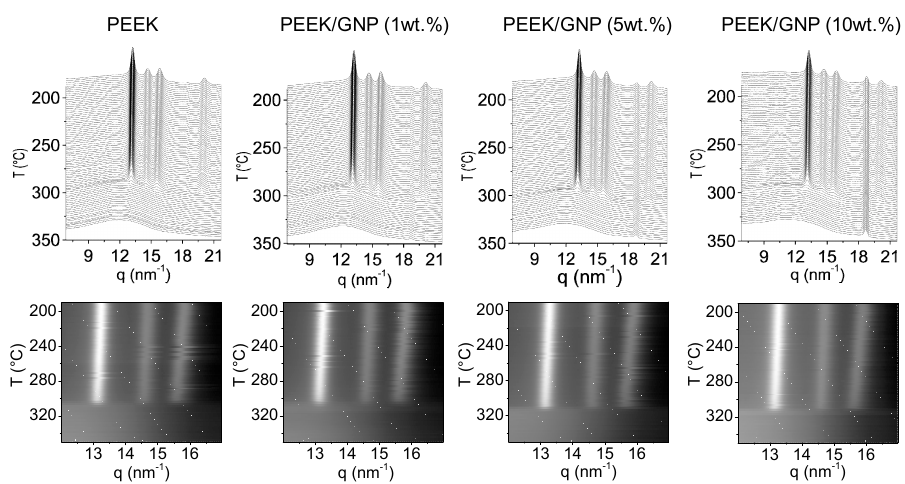
Figure 6. Simultaneous time-resolved wide angle synchrotron X-ray radiation (WAXS) patterns (upper) and intensity profiles of three main PEEK diffractions (down) for crystallization from melt of PEEK and PEEK/GNP nanocomposites.